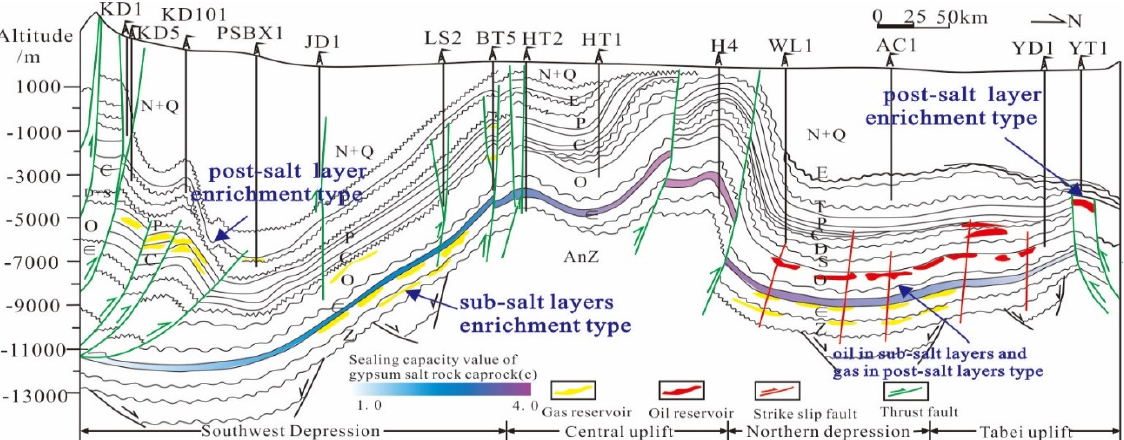
Figure 10. Sealing capacity and hydrocarbon distribution of Cambrian caprock in the Tarim Basin (see Figure 8 for section position). The “sub − salt layers enrichment type”, “post − salt layers enrichment type”, and “oil in sub − salt layers and gas in post − salt layers type” are the three main hydrocarbon enrichment styles in the study area. The “post − salt layers enrichment type” is distributed in the areas with poor sealing ability of caprock and developed thrust faults at the edge of the basin, such as south of the southwest depression; the “sub − salt layers enrichment type” is mainly distributed in the areas with good sealing ability of caprock and undeveloped faults, such as north of the southwest depression; and the “oil in sub − salt layers and gas in post − salt layers type” is distributed in areas with good sealing capacity of caprock, and fault activity is poor or strong in the early period and weak in the late period, such as the northern depression.